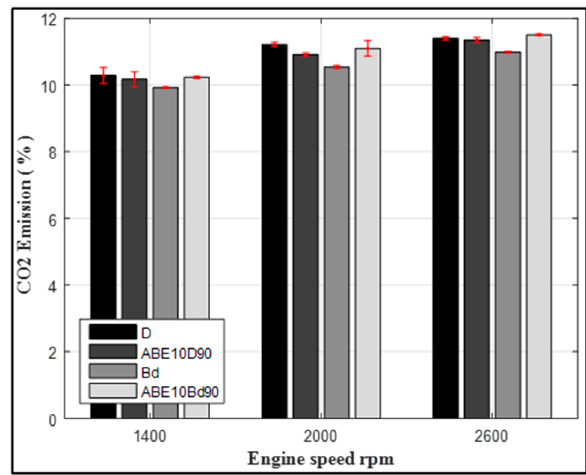
Figure 13. CO emissions of test fuels.